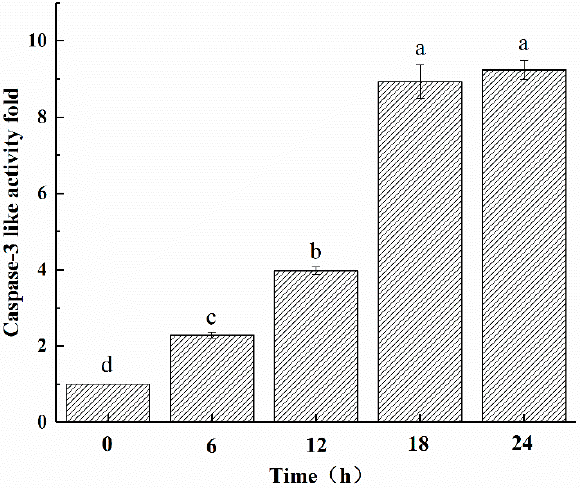
Figure 7. Caspase-3-like activity analysis of Sf9 cells with 7.5 μ g/mL ZC-14 treatment for 0, 6, 12, 18 and 24 h, respectively. All data were expressed as mean ± SD of three independent experiments. Different letters above bars indicate significant differences between different treatments ( p < 0.05) using ANOVA, followed by Duncan’s test.